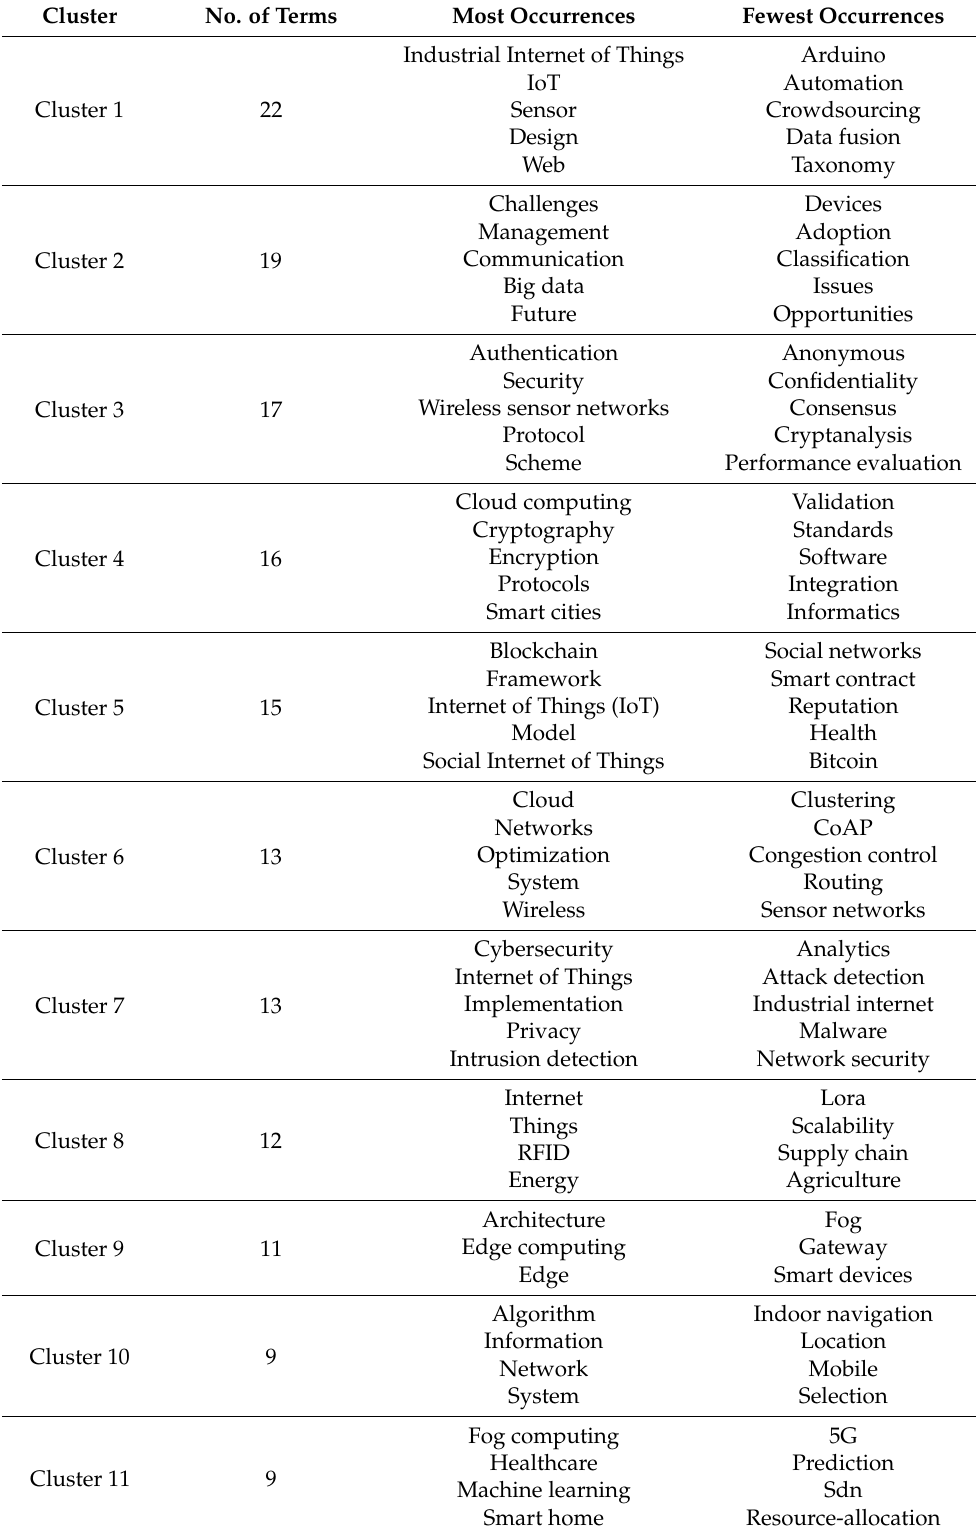
Table 5. Synthesis of VOSviewer keyword occurrences on the economic influence of